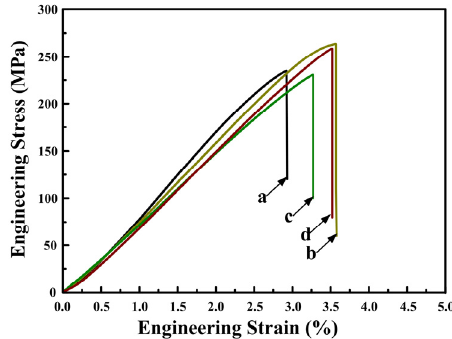
Figure 4. Microstructures of primary Mg 2 Si in hot ‐ extruded (extruding temperature: 460 °C) and T6 treated (solution temperature and time: 500 °C/2h, aging temperature and time: 175 °C/8h) alloys: